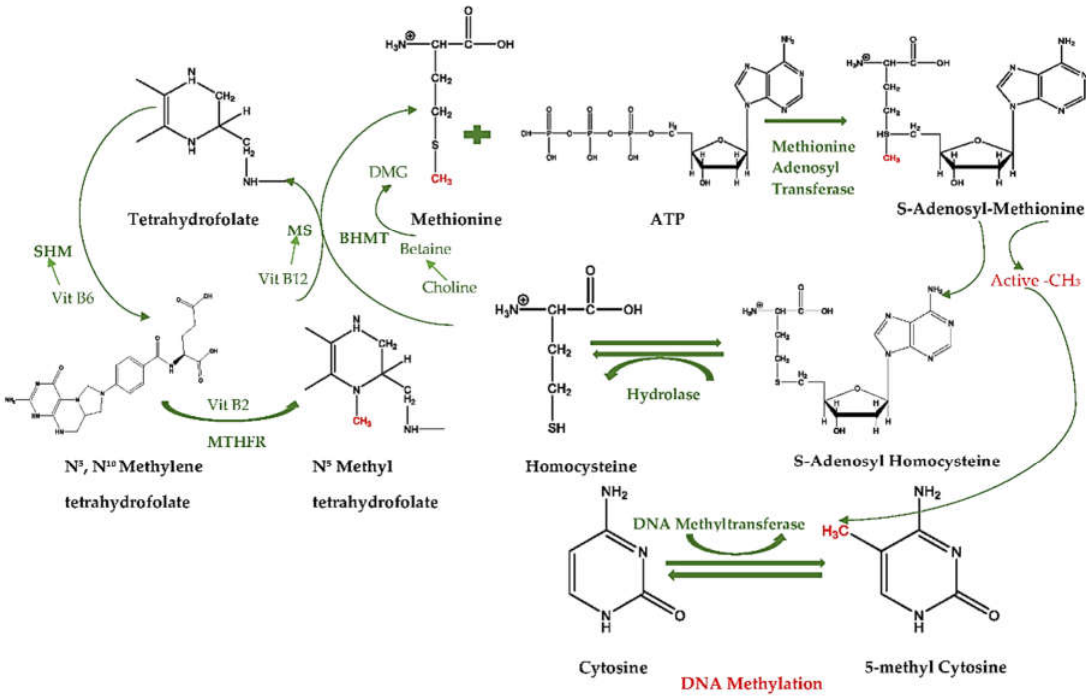
Figure 1. One-Carbon Cycle and DNA Methylation. MTHFR, methylenetetrahydrofolate reductase; SHMT, serine hydroxymethyltransferase; MS, methionine synthase; BHMT, betaine homocysteine methyltransferase; DMG, dimethylglycine.